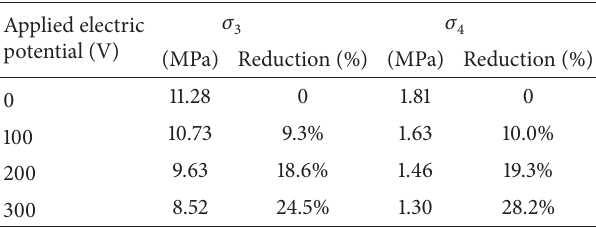
Table 3: Comparison of peak stresses for angle ply